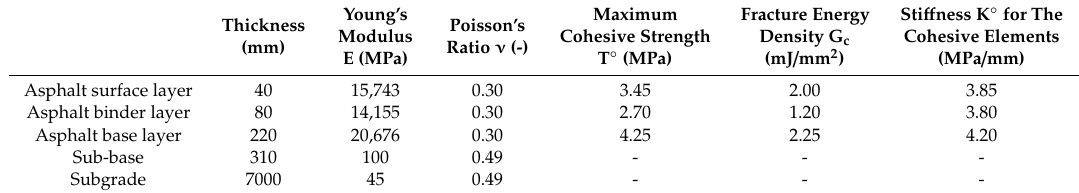
Table 4. Geometry and material properties of asphalt pavement according to RStO